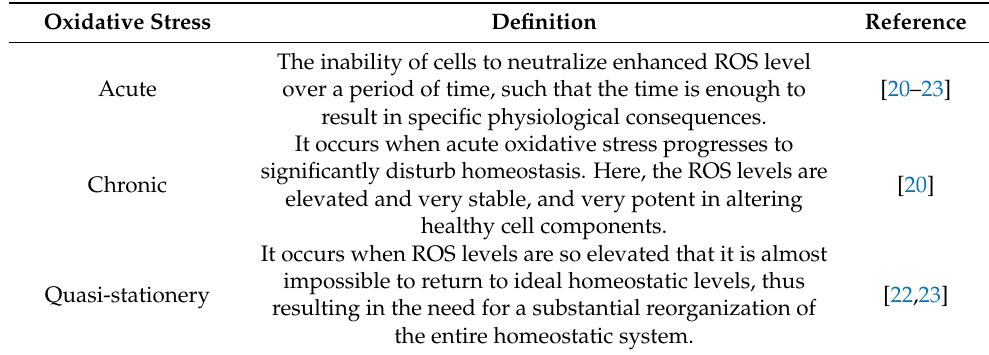
Table 2. Types/Levels of oxidative